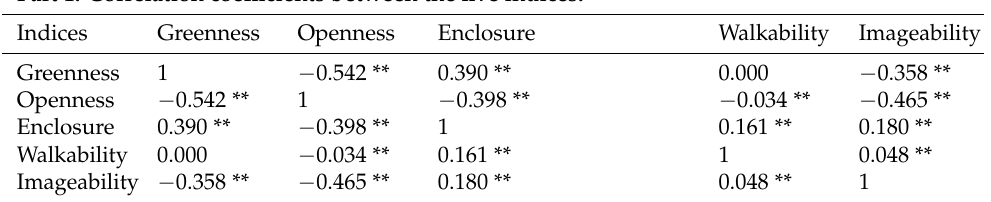
Table 3. Correlation matrices of the initial visual elements and their indices. The five indicators have been